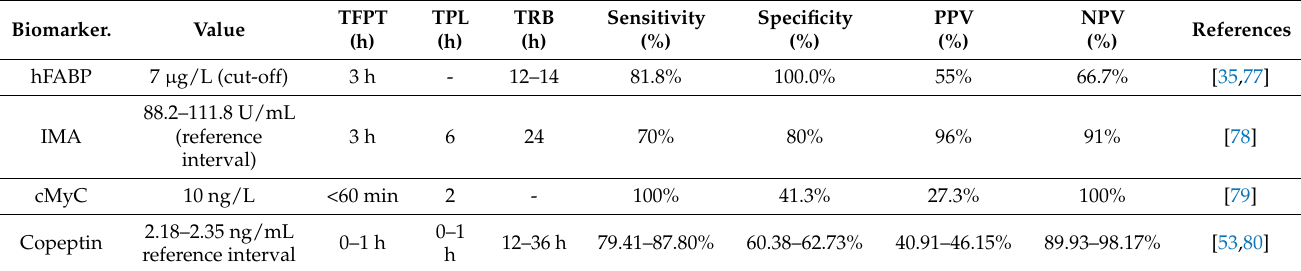
Table 5. Characteristics of newer biomarkers used in the diagnosis of acute myocardial infarction.